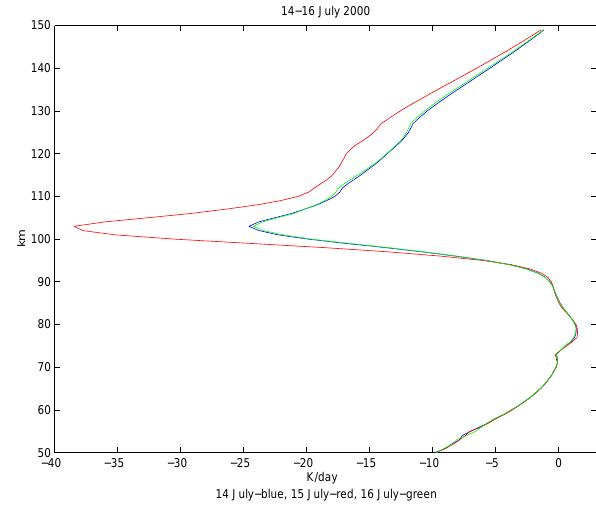
Fig. 8. Daily net particle heating rates. Fig. 9. Radiative cooling/heating rates of CO